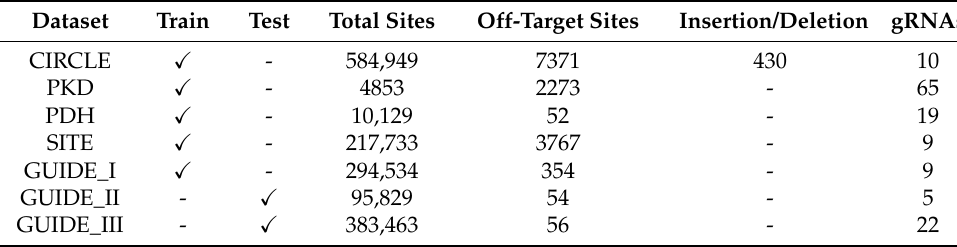
Table 1. Experimental datasets details validated by different methods.